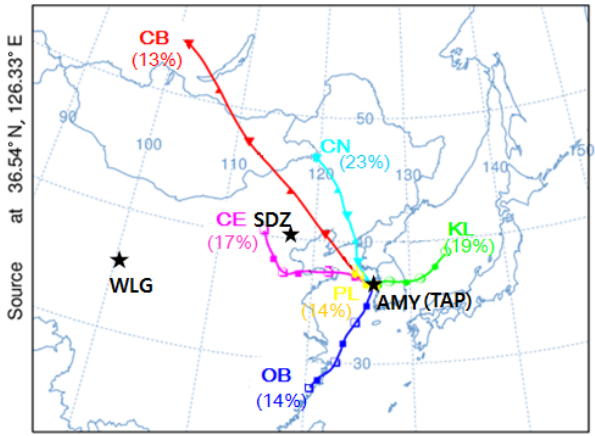
Figure 1. A total of 70 air-parcel back-trajectories were calculated for 72h periods at 3h intervals from May 2014 to August 2016 us- ing the HYSPLIT model in conjunction with KMA UM GDAPS data at a 25km × 25km resolution. Station locations are as fol- lows: WLG (Waliguan; 36.28 ◦ N, 100.9 ◦ E; 3816ma.s.l.), SDZ (Shandianzi; 40.65 ◦ N, 117.12 ◦ E; 287ma.s.l.), and AMY (An- myeondo; 36.53 ◦ N, 126.32 ◦ E; 86ma.s.l.). TAP (Tae-Ahn Penin- sula; 36.73 ◦ N, 126.13 ◦ E; 20ma.s.l.) is around 28km northeast